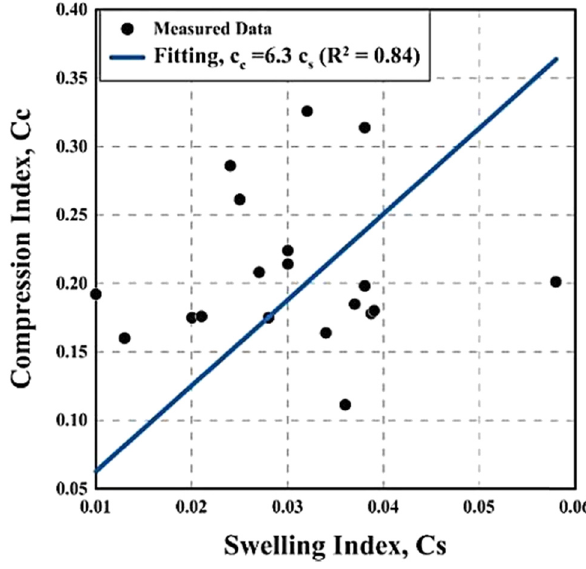
Figure 21: Compression index versus swelling index